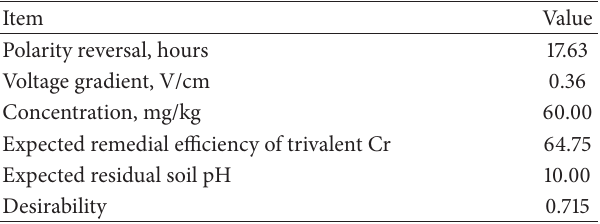
∗ Confidence interval. ∗∗ Prediction interval. Table 9: Optimal factor levels required to maximize remedial efficiency of trivalent Cr.